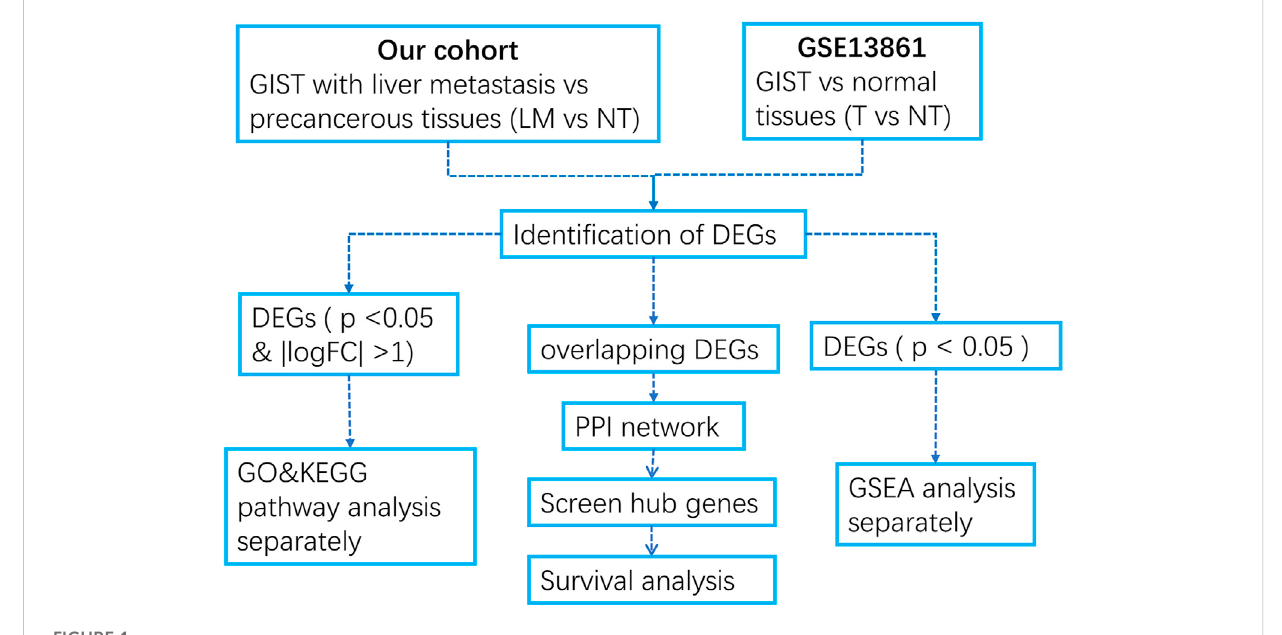
FIGURE 1 Flow diagram of the data collection and method implementation in this